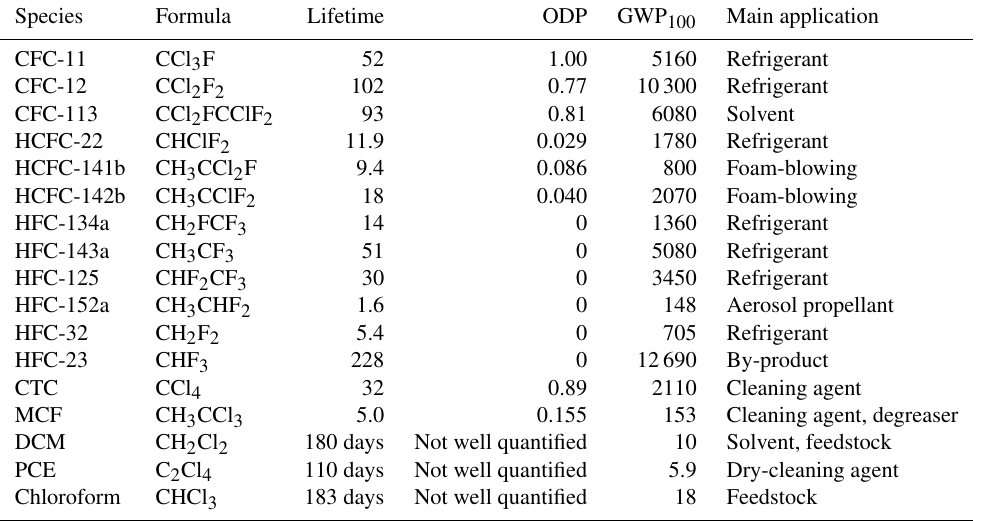
Table 1. Halocarbons considered in this study. Atmospheric lifetime estimates, ozone-depletion potentials (ODPs) and global warming po- tentials (100-year time horizon, GWP 100 ) are taken from the 2018 Scientific Assessment on Ozone Depletion (Engel et al., 2019). Lifetimes are quoted in years unless otherwise